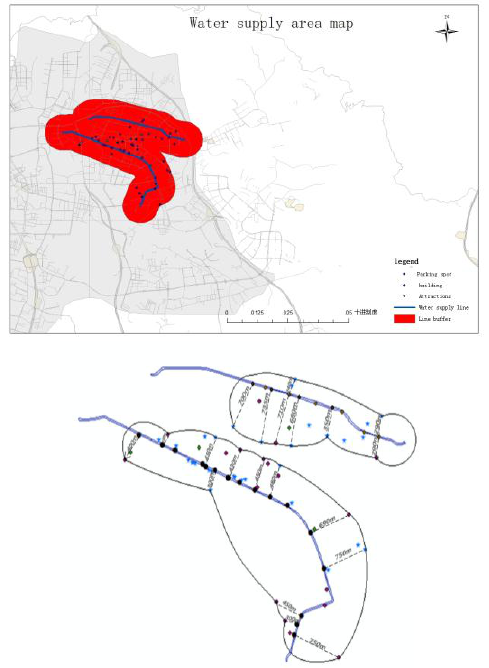
Figure 6. Line buffer comparison chart (a. Traditional buffer; b.Irregular